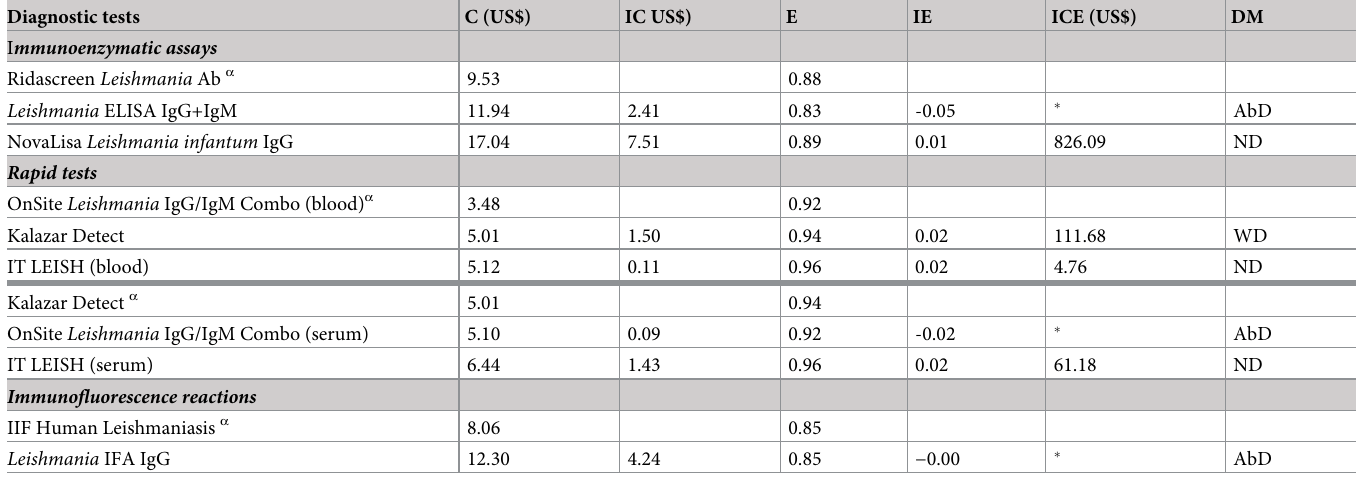
Table 5. Cost-effectiveness analysis for visceral leishmaniasis diagnostic tests in HIV-uninfected patients, stratified by test methodology. Diagnostic tests